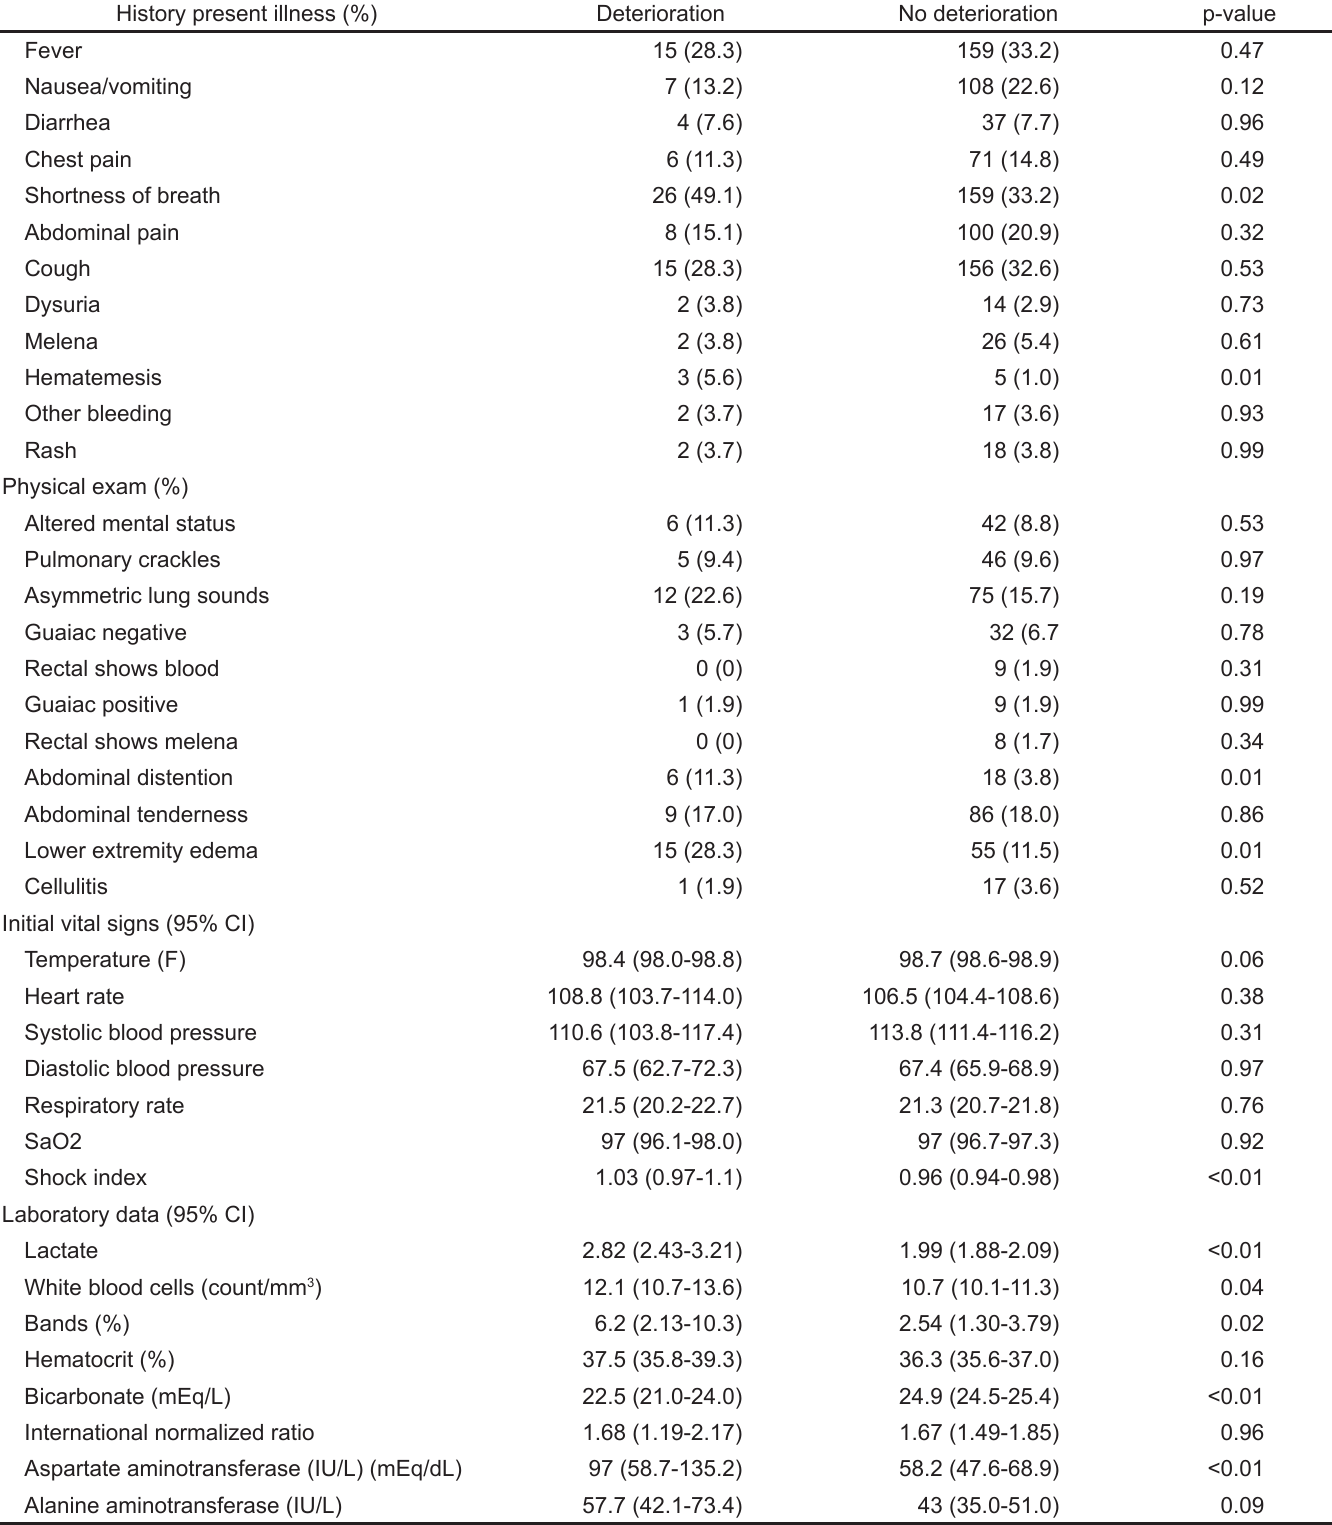
Table 3. Clinical characteristics of patients by outcome. Factors with p<0.1 were included as candidate variables in the multiple regression